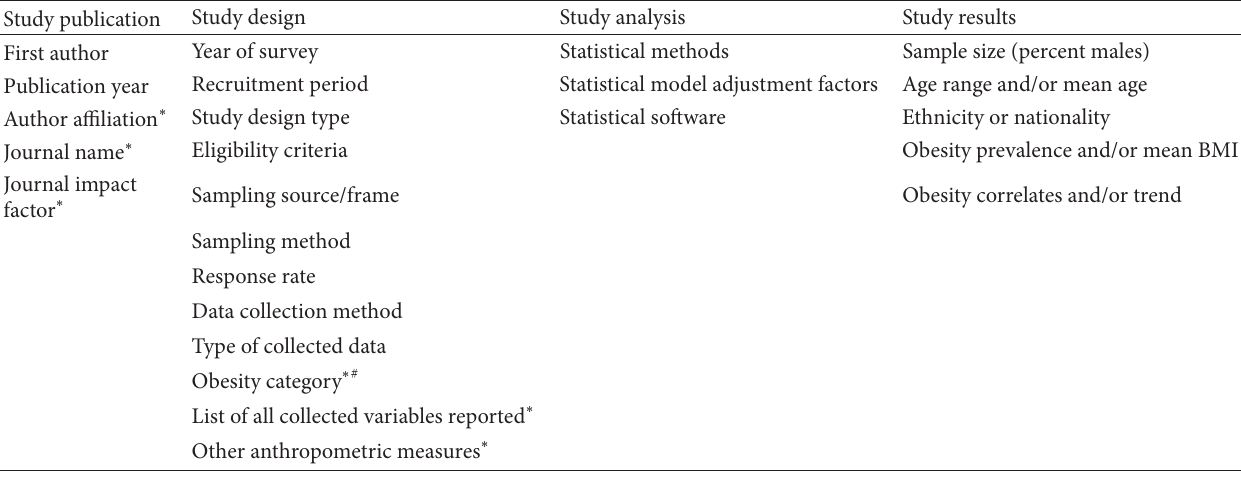
Table 1: Information extracted from each reviewed study by study domain.